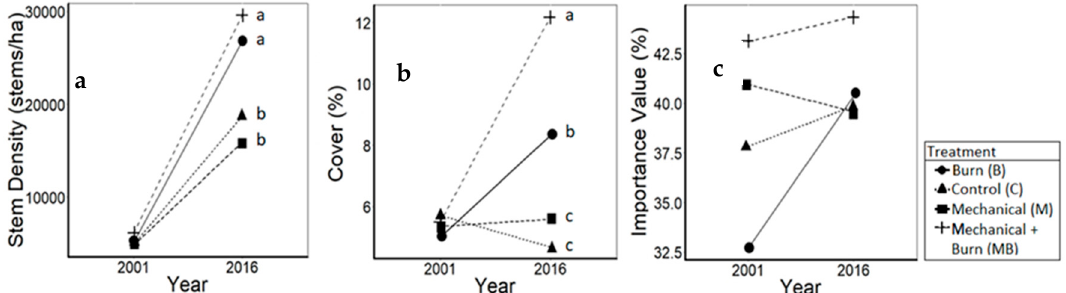
Figure 2. Oak ( a ) stem density (stems / ha), ( b ) absolute cover (%), and ( c ) importance value results Figure 2. Oak a ) stem density (stems/ha), b ) absolute cover (%), and c ) importance value results showing the 4 treatment e ff ects (control = C, burned = B, mechanical removal of stems < 10 cm DBH showing the 4 treatment effects (control = C, burned = B, mechanical removal of stems <10 cm DBH = = M, and mechanical removal of stems < 10 cm DBH + burned = MB) from 3 analysis of variance (ANOVA). Post-hoc comparison (Tukey’s Honest Significant Di ff erence Test. THSD) letters show di ff erences between treatment e ff ects from 2001 to 2016. Table 3. Change in abundancy for the secondary vegetation guilds after 15 years (2001–2016) of repeated treatments (control = C, burned = B, mechanical removal of stems < 10 cm in diameter at breast height (DBH) = M, and mechanical removal of stems < 10 cm DBH + burned = MB). Means, standard deviations, and p -values for each ANOVA are indicated in parentheses next to each guild. Lowercase letters identify the statistically di ff erent treatment e ff ect at p <